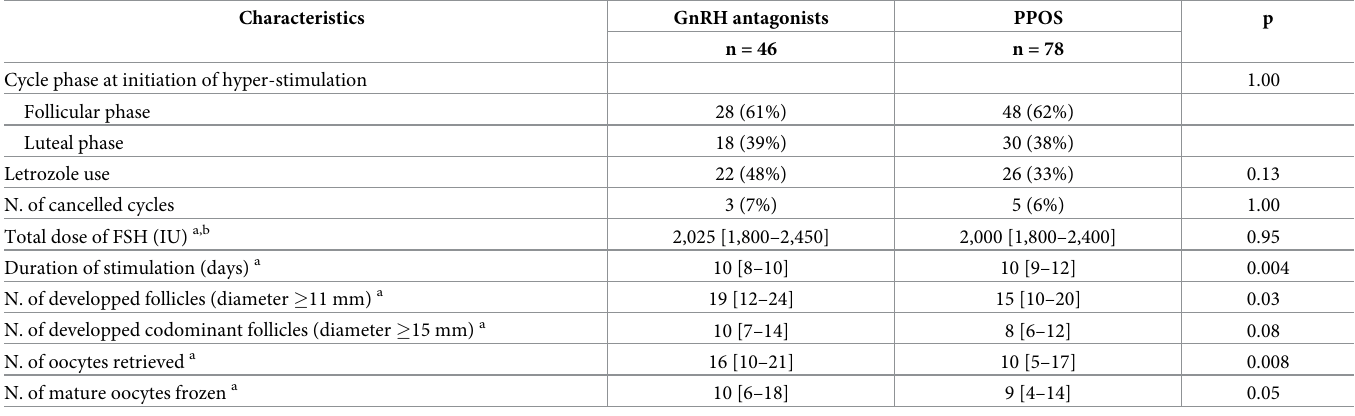
Table 2. Baseline clinical characteristics of the study